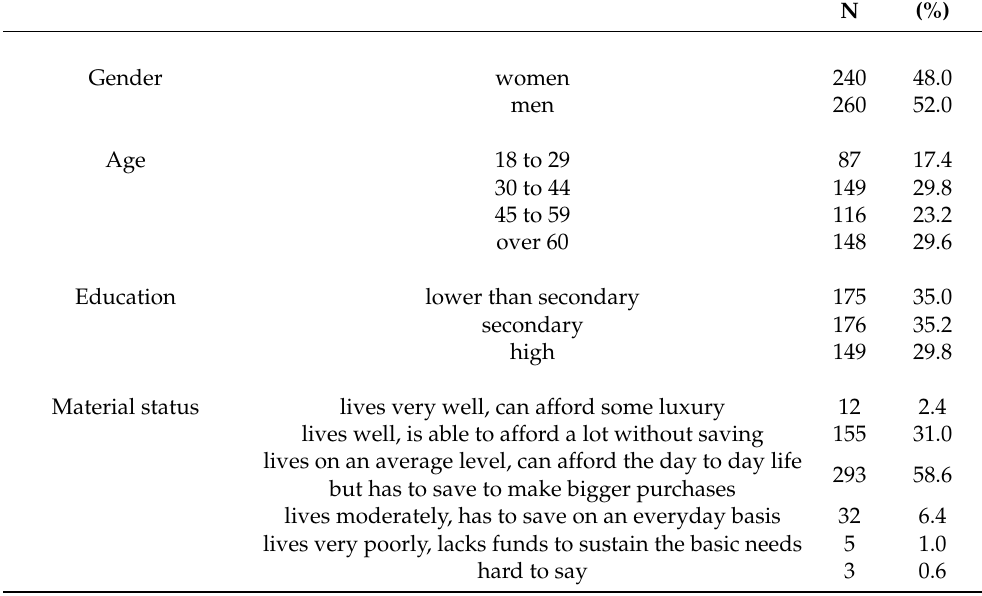
Table 1. General characteristics of